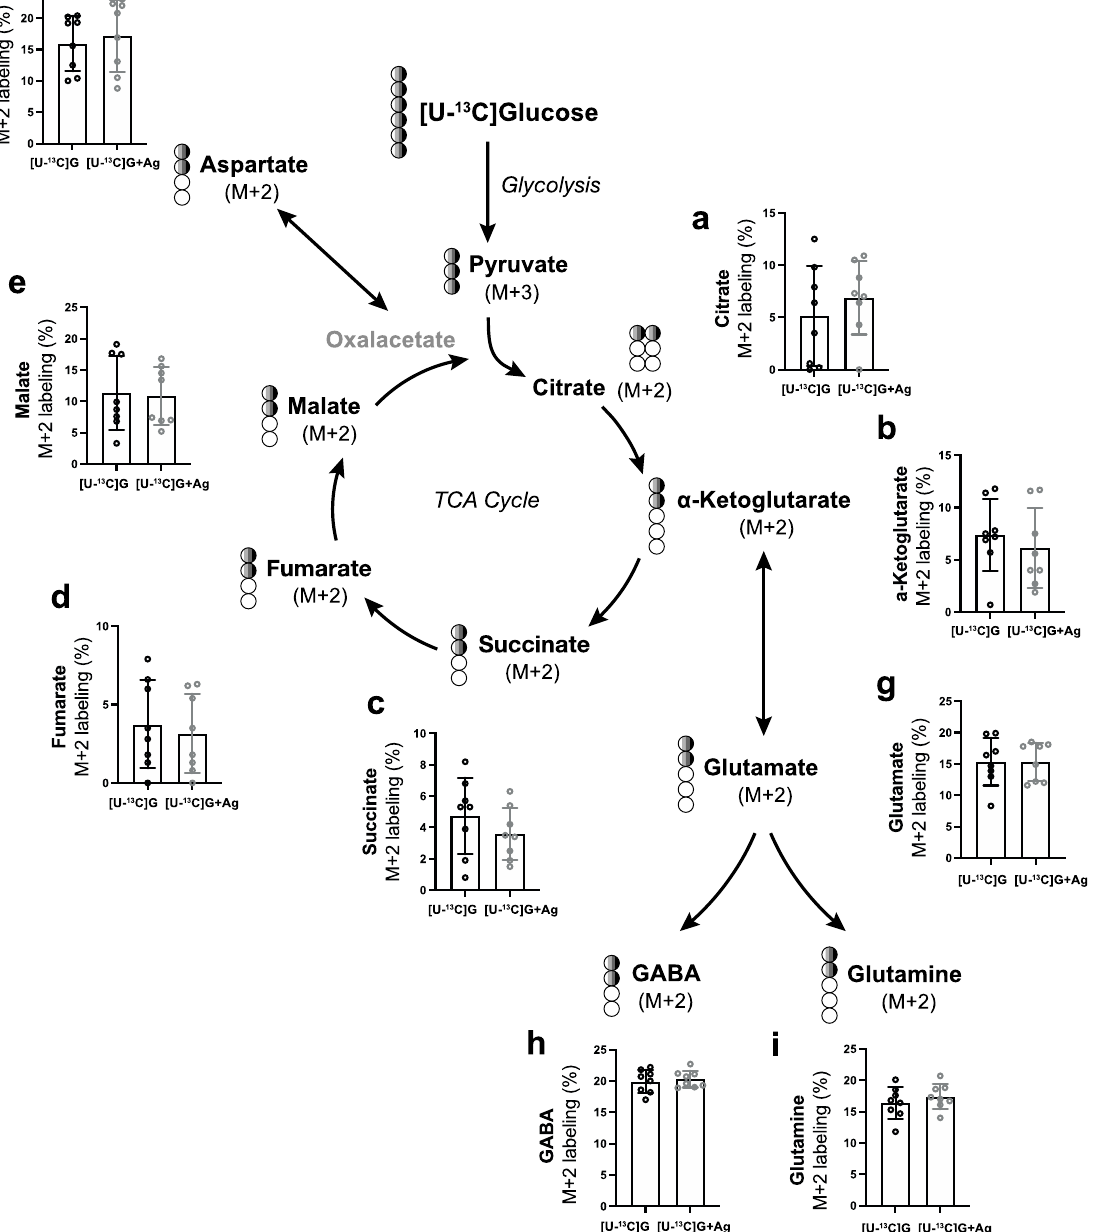
Figure 5. Retinal metabolism of [U- 13 C] glucose in response to 3,5-DHBA (Ag) treatment. ( a – i ) Retinal explants were incubated for 2 h with 6 mM [U- 13 C]glucose in the absence or presence of 5 mM of 3,5-DHBA. No significant changes in relative abundance of 13 C labeling were found in any of the measured metabolites. Values are presented as mean ± S.D. ( n = 8 retinal quarters originating from eight different whole retinas). Statistics: Unpaired t